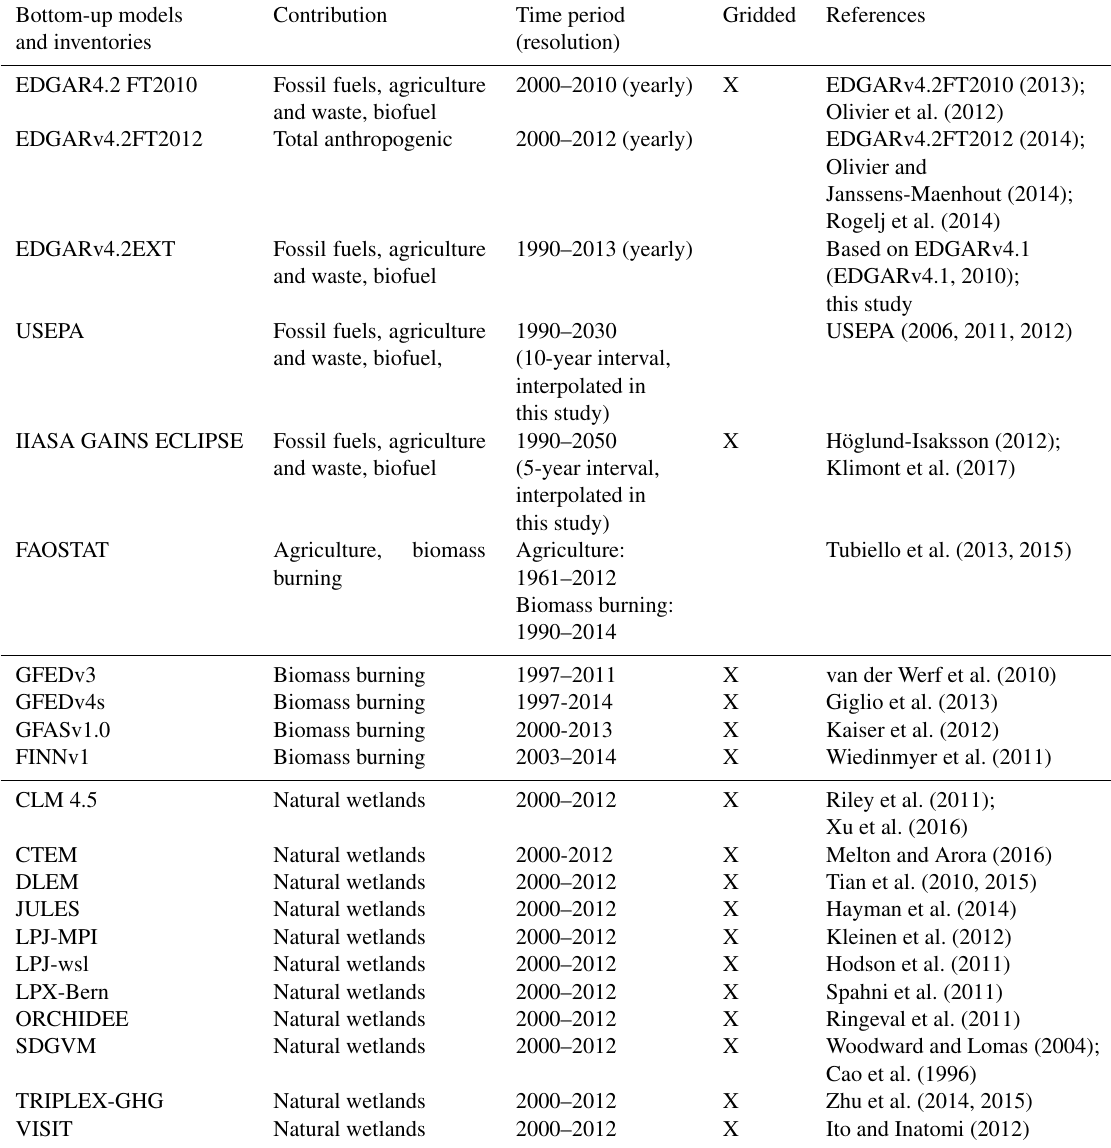
Table 2. List of the bottom-up studies included in this